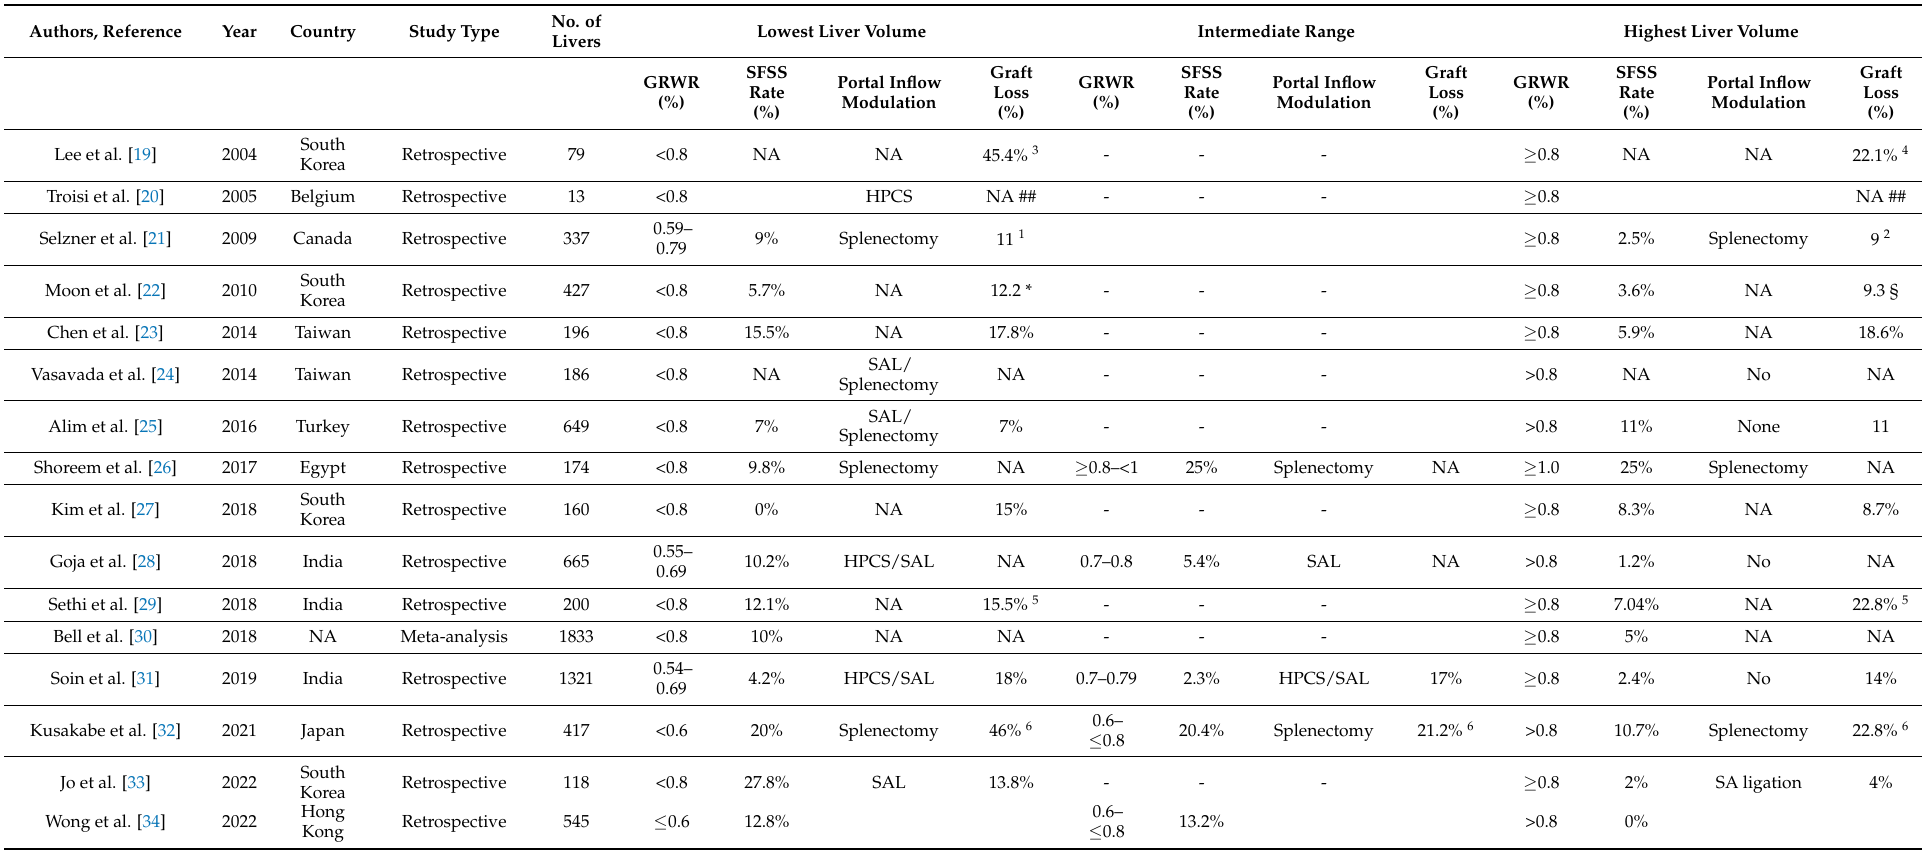
Table 1. Literature overview on outcomes according to accepted liver volume cutoffs for living donor liver